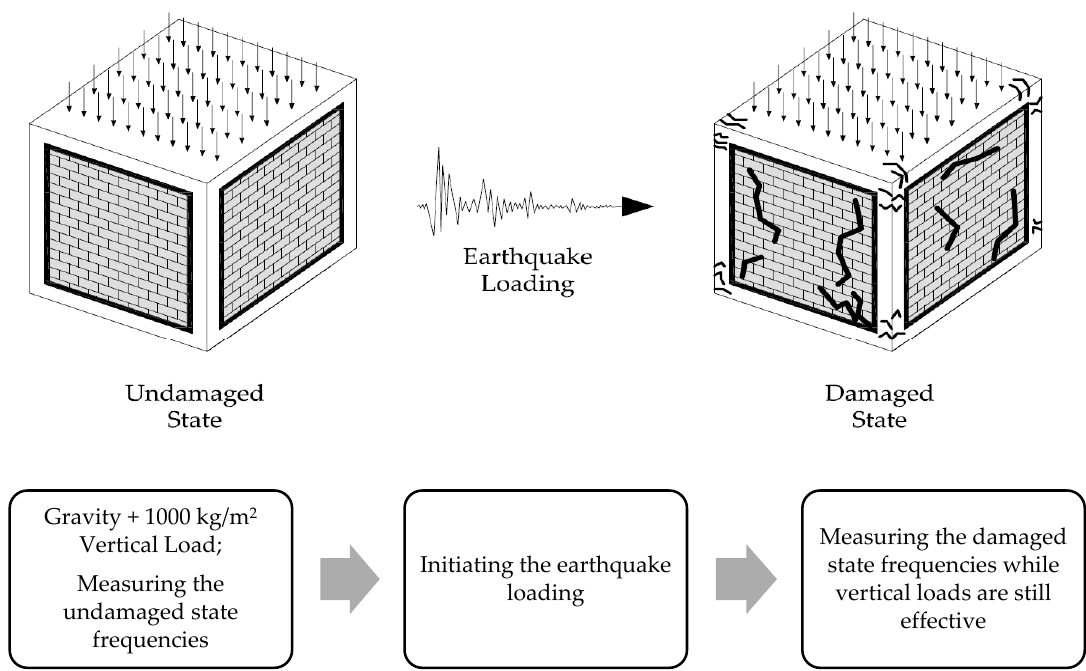
Figure 18. Loading and measuring procedure for the large size analyses.